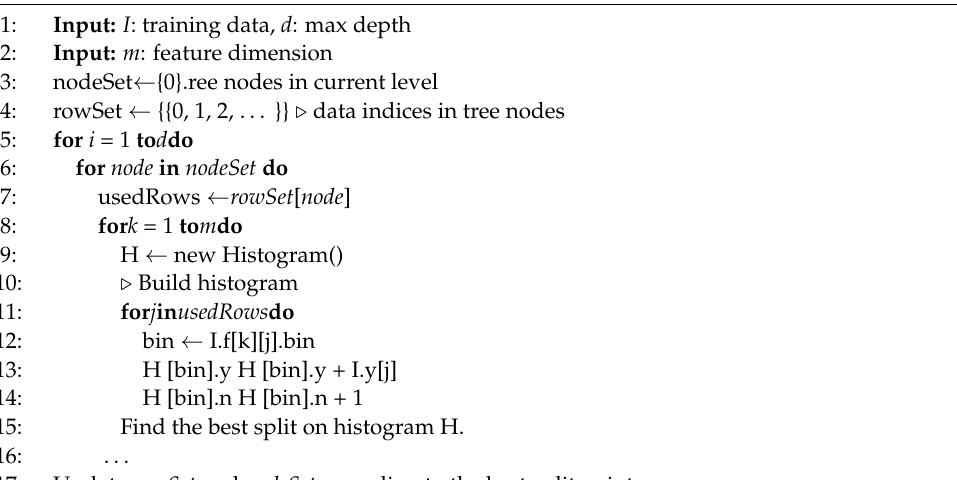
Algorithm A3 LightGBM Pseudo-Code